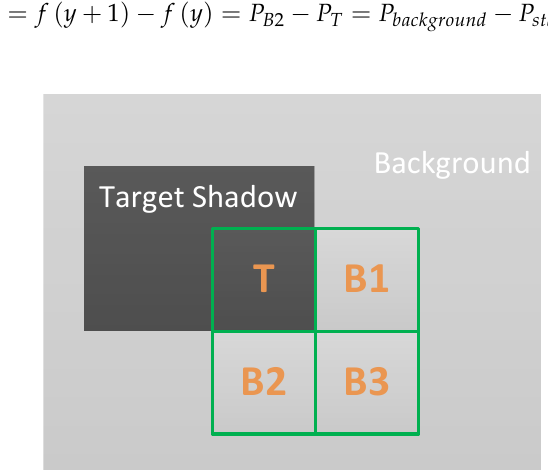
Figure 4. Schematic diagram of the edge region between target shadow and background. Dark gray rectangle represents target shadow and light one is the background. Blocks in green outer contours are 4 adjacent pixels (edge